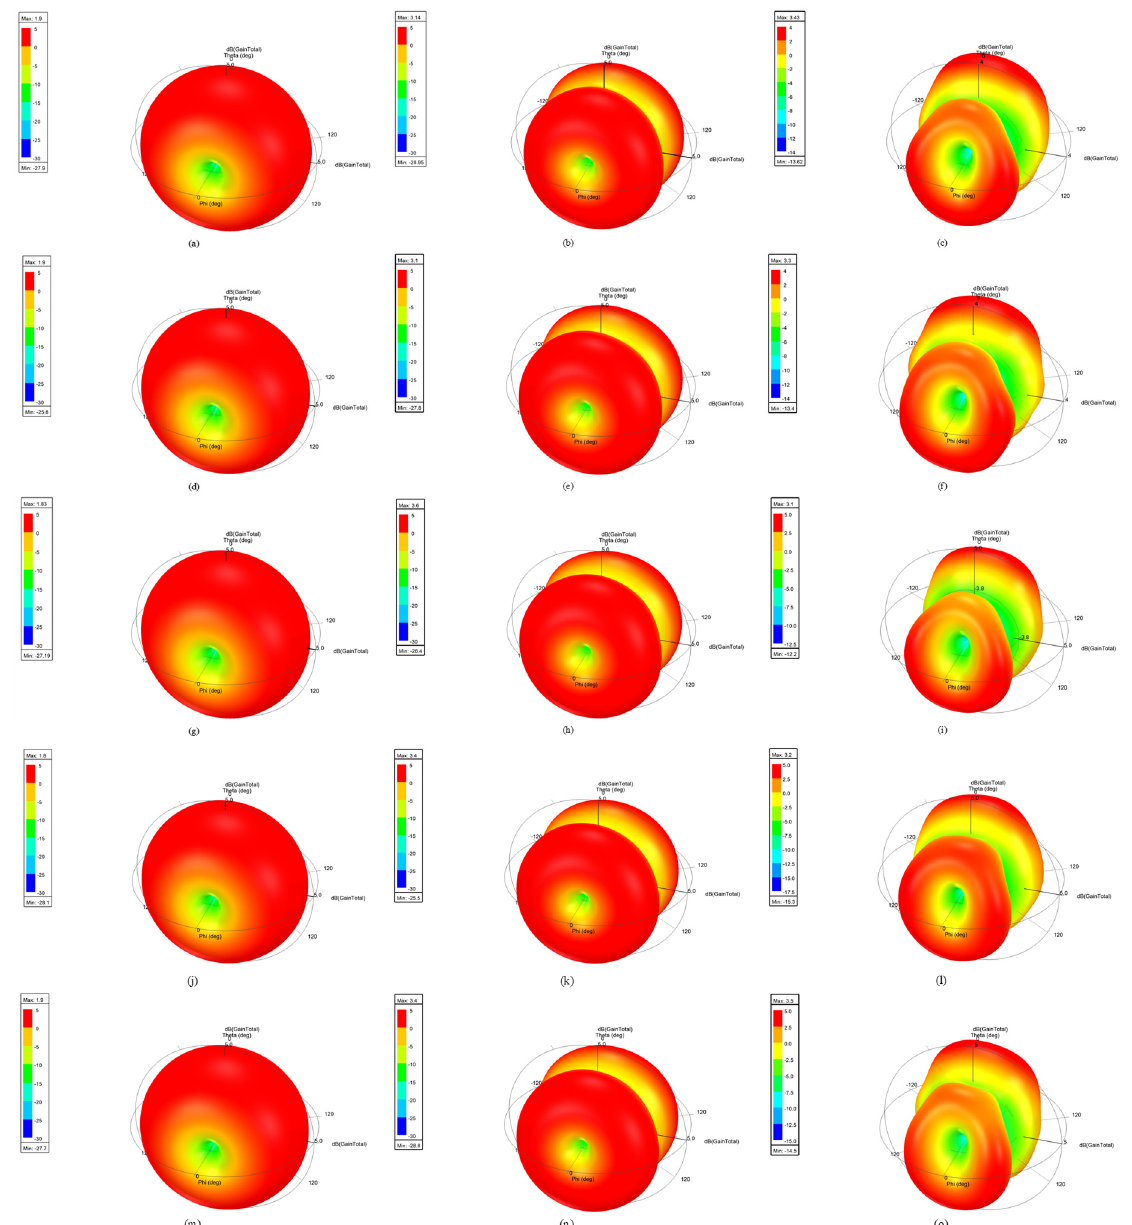
Figure 13. Simulated results from the obtained structure of the tri-band antenna of HFSS: ( a ) 3D polar plot of antenna model x (1) at 2.17 GHz; ( b ) 3D polar plot of antenna model x (1) at 5.28 GHz; ( c ) 3D polar plot of antenna model x (1) at 7.45 GHz; ( d ) 3D polar plot of antenna model x (2) at 2.17 GHz; ( e ) 3D polar plot of antenna model x (2) at 5.28 GHz; ( f ) 3D polar plot of antenna model x (2) at 7.45 GHz; ( g ) 3D polar plot of antenna model x (3) at 2.17 GHz; ( h ) 3D polar plot of antenna model x (3) at 5.28 GHz; ( i ) 3D polar plot of antenna model x (3) at 7.45 GHz; ( j ) 3D polar plot of antenna model x (4) at 2.17 GHz; ( k ) 3D polar plot of antenna model x (4) at 5.28 GHz; ( l ) 3D polar plot of antenna model x (4) at 7.45 GHz; ( m ) 3D polar plot of antenna model x (5) at 2.17 GHz; ( n ) 3D polar plot of antenna model x (5) at 5.28 GHz; ( o ) 3D polar plot of antenna model x (5) at 7.45